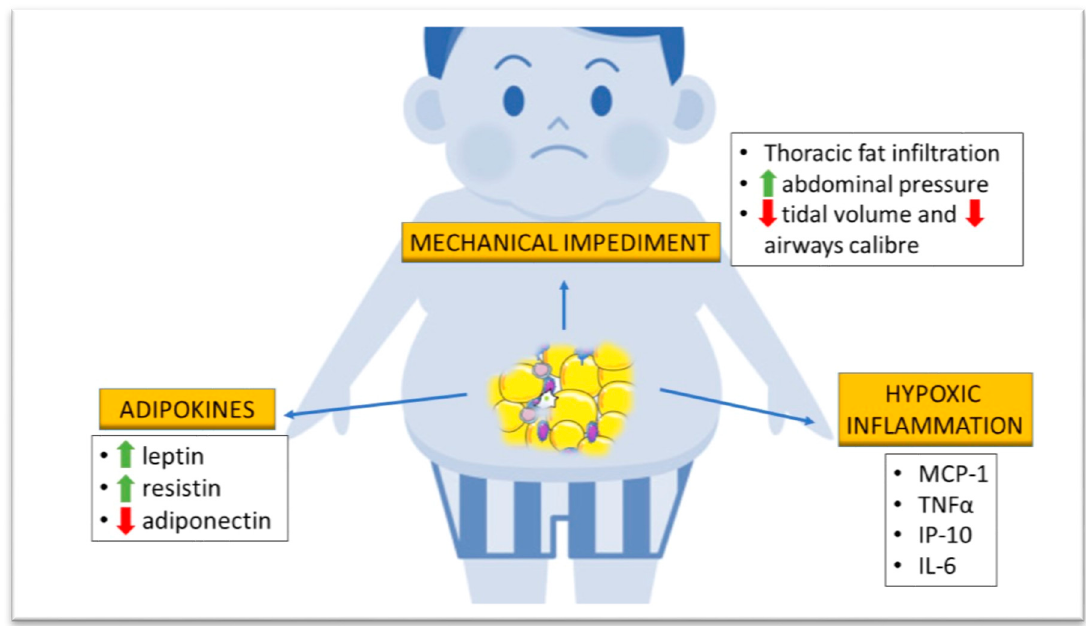
Figure 1. Pathological mechanisms of obesity that might influence lung function in children. Abdominal tissue deposition increases (upwards green arrow) abdominal pressure, forcing superficial ventilation and a consequent decrease (downwards red arrow) in tidal volume and airway caliber. Fat accumulation determines higher serum concentration of leptin and resistin, together with a decrease of circulating adiponectin. Excessive abdominal fat results in hypoxia with production of pro-inflammatory cytokines such as monocyte chemoattractant protein 1 (MCP-1), tumor necrosis factor α (TNF α ), IFN- γ -inducible protein 10 (IP10), and interleukin-6 (IL-6).